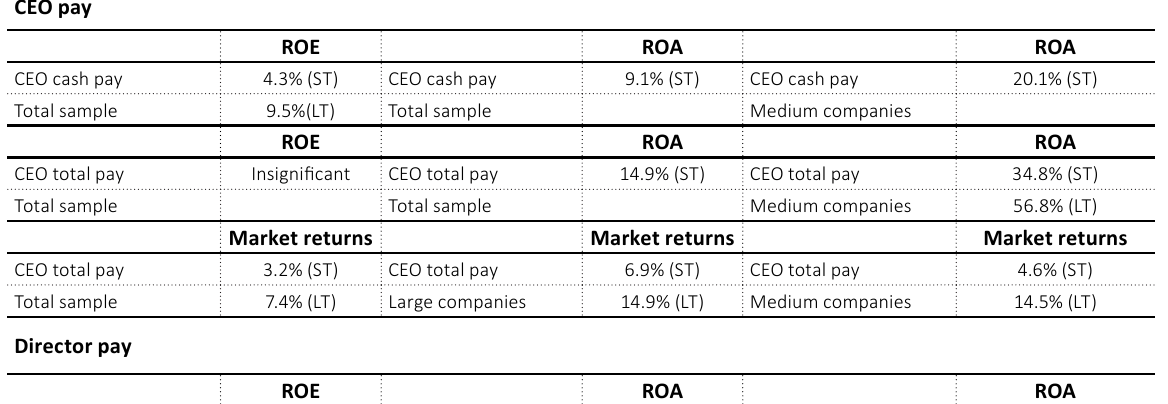
Table 4. Summary of the cumulative effect of a 10% change in performance on pay CEO